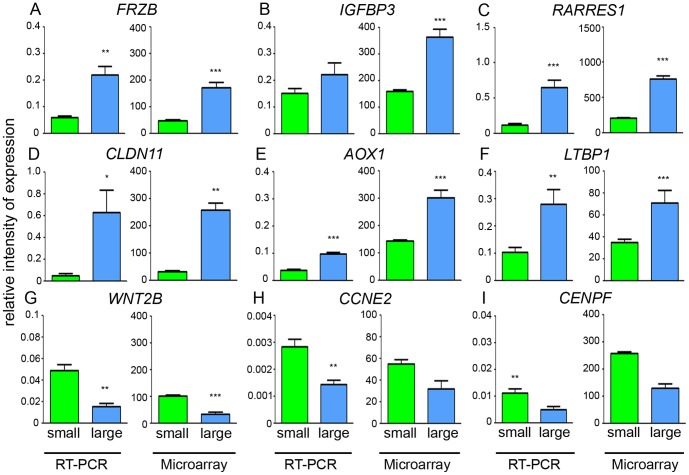
Measurement of gene expression by qRT-PCR.The data are shown as the mean ± SEM (n = 7 for small follicle group, n = 4 for large follicle group). qRT-PCR values were determined from the mean of the ratio of 2−ΔCt of the target genes to cyclophilin A (PPIA) and glyceraldehyde phosphate dehydrogenase (GAPDH), and the microarray values are signal intensities (normalized but not log transformed). Significantly different results for qRT-PCR were determined by Student's t-test. The P values for the microarray results are corrected for multiple testing using the FDR (*P<0.05, **P<0.01 and ***P<0.001).